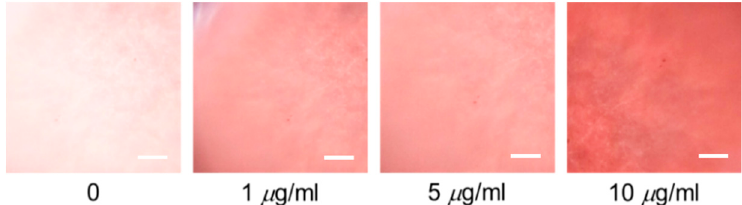
Figure 5. Optical textures of the DDLC device in the presence of BSA concentrations of 0 to 10 µg/mL. The scale bar is 300 µm.